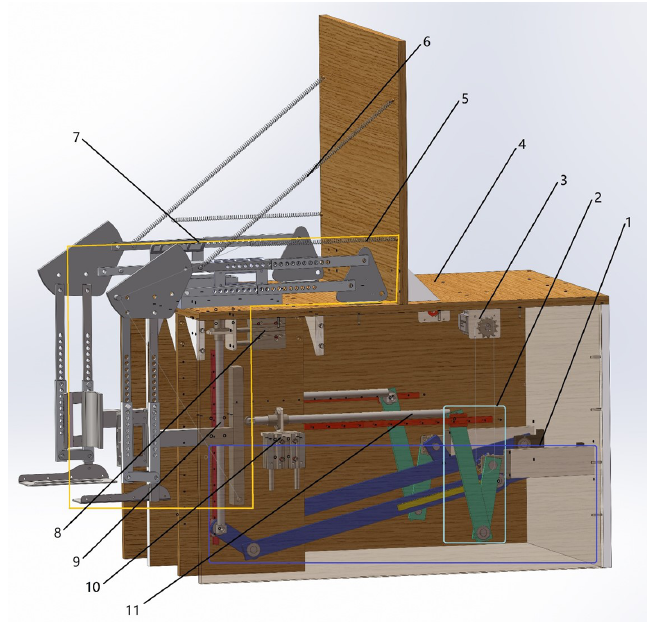
Figure 2. Three-dimensional diagram of the lower limb rehabilitation training device. 1—drive mechanism 2; 2—drive mechanism 1; 3—motor; 4—seat; 5—calf spring; 6—thigh spring; 7—lower limb exoskeleton; 8—cylinder 1; 9—thigh push rod; 10—cylinder 2; 11—calf push rod.